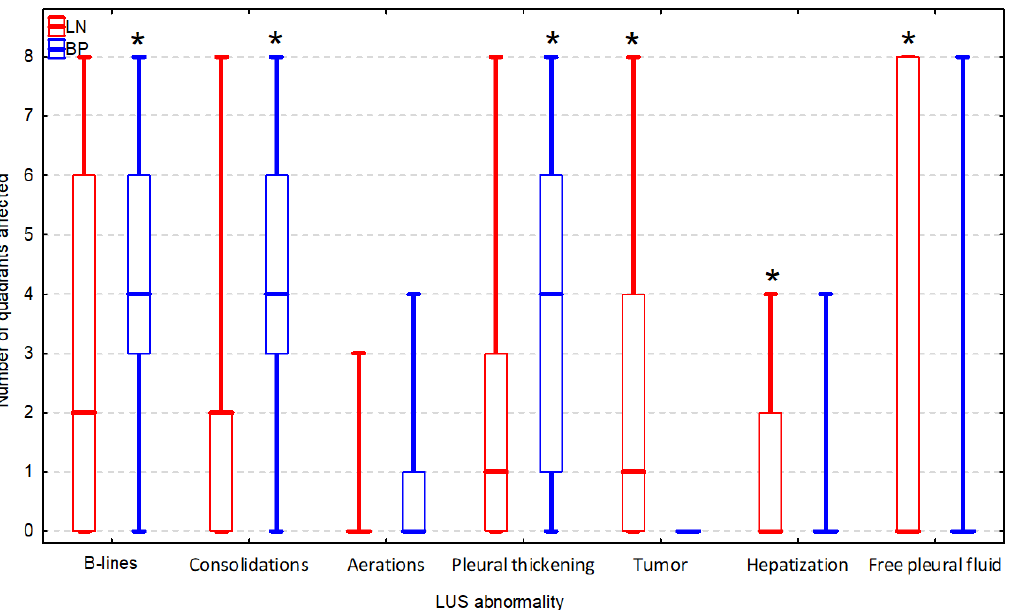
Figure 14. The number of quadrants in which a given lung ultrasound (LUS) abnormality was detected in dogs with lung neoplasm (LN, n = 35) and bacterial pneumonia (BP, n = 31). Bars, boxes, and whiskers correspond to the median, interquartile range (IQR), and range, respectively. Asterisks (*) indicate a group with significantly higher number of quadrants affected by a given LUS abnormality according to the Mann–Whitney U test.